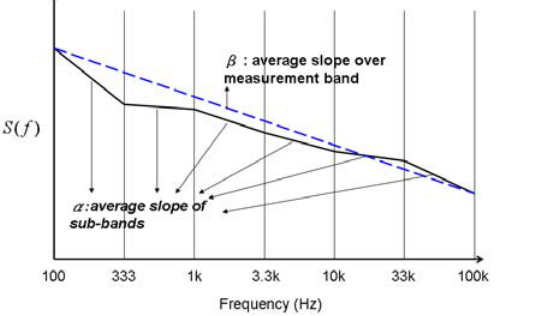
Figure 1. Illustration of α and β for logarithmically equidistant sub-band boundaries. n S ( f ) is the power density spectrum of the fluctuations of the sensor